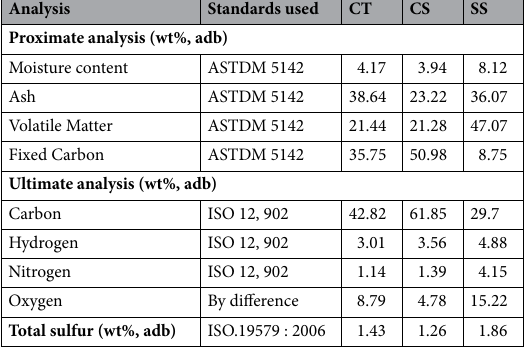
Table 1. Physicochemical analysis results. CT coal tailing, CS coal slurry, SS sewage sludge, adb air dried basis, wt% weight